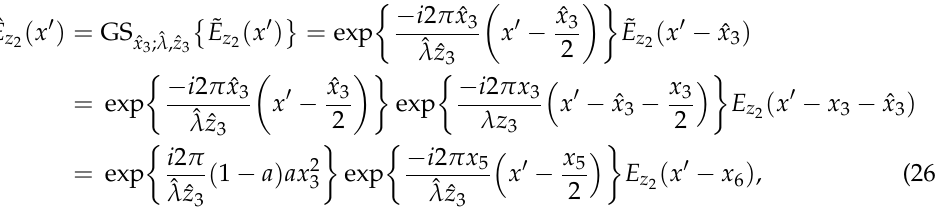
(cid:9) ( u ) exp (cid:8) − i π u 2 / λ z 1 1